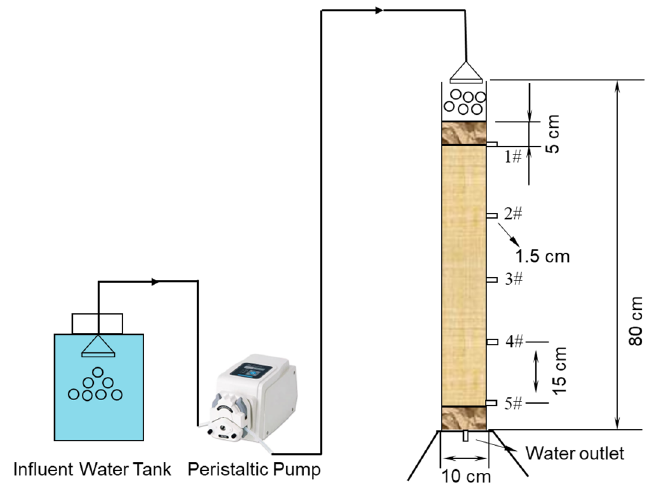
Figure 1. Schematic diagram of the column system.